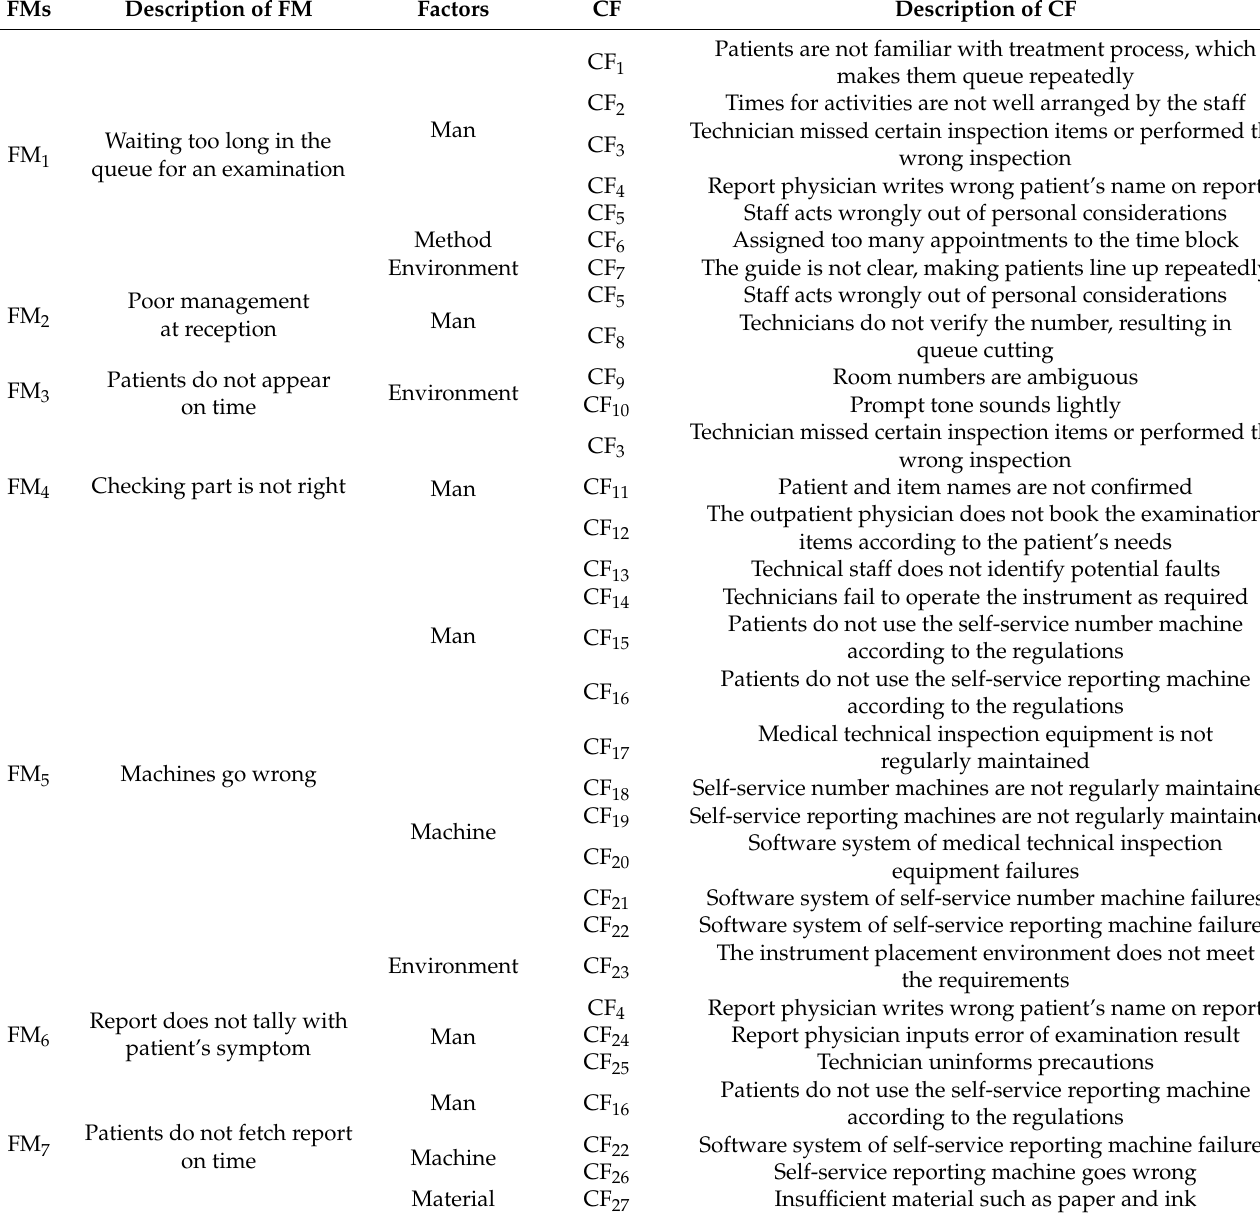
Table 1. List of FMs across the medical examination process in the targeted